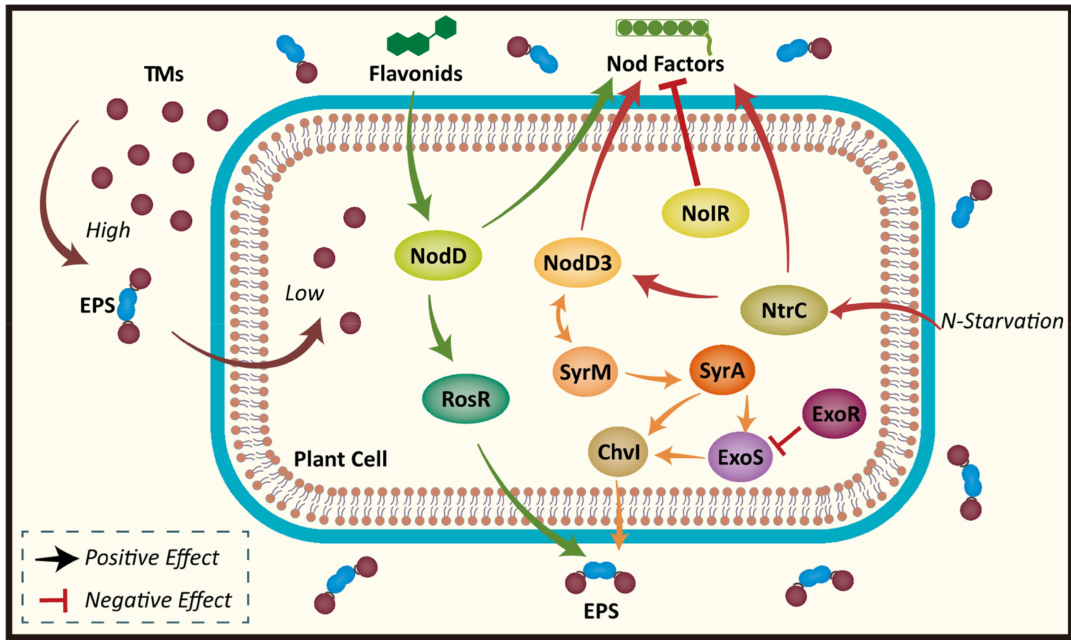
Figure 4. Schematic diagram of EPS binding to TMs in soil under the regulation of relevant genes. Different colored arrows play an active role in the process, and T-shaped arrows indicate an inhibitory role in the